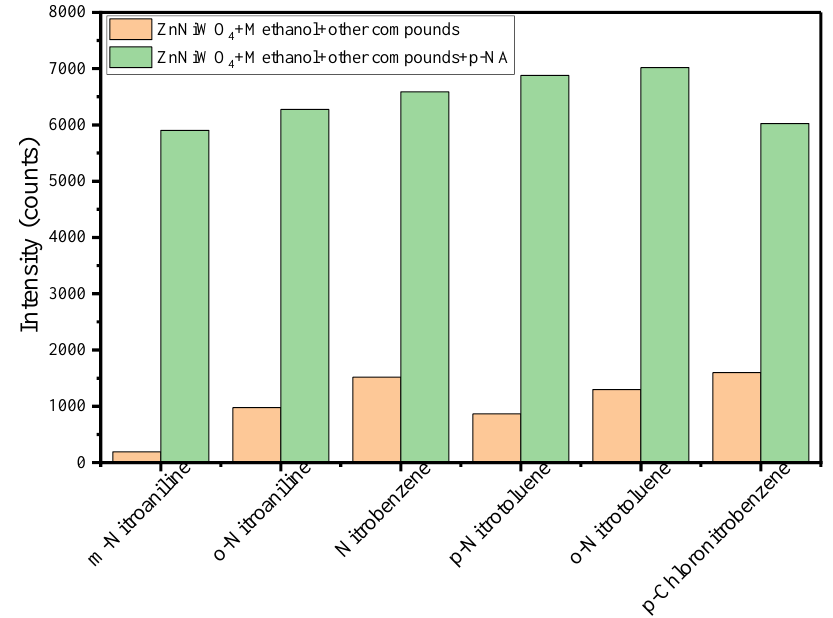
Figure 12. Anti-interference test for ZnNiWO4 for p-NA in presence of its analog .